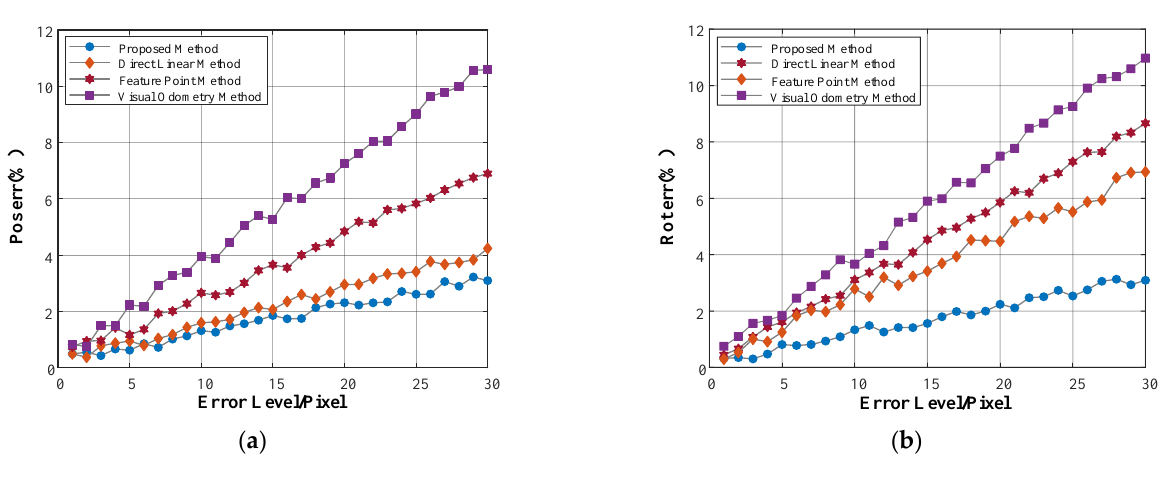
Figure 9. The influence of the different image measurement noise levels on the measurement accuracy of the algorithm. ( a ) Attitude measurement error; ( b ) Position measurement error.